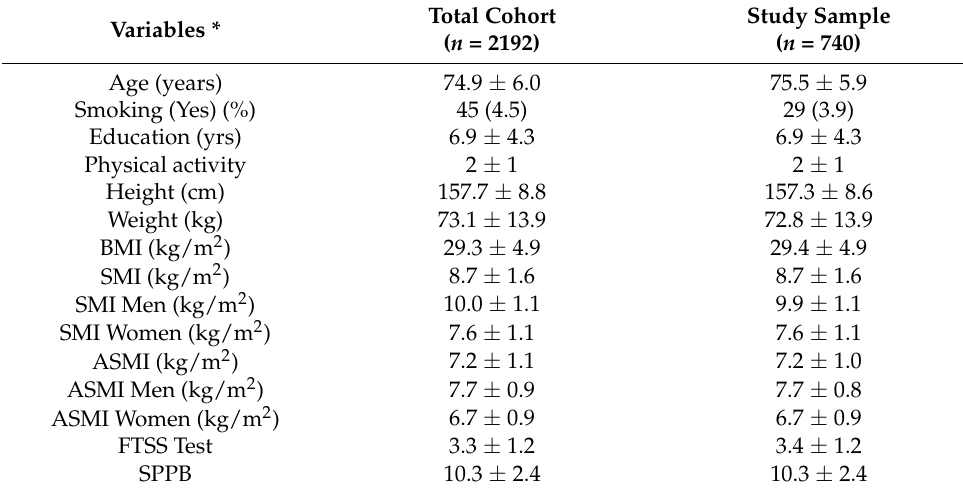
Total Cohort ( n = 2192)